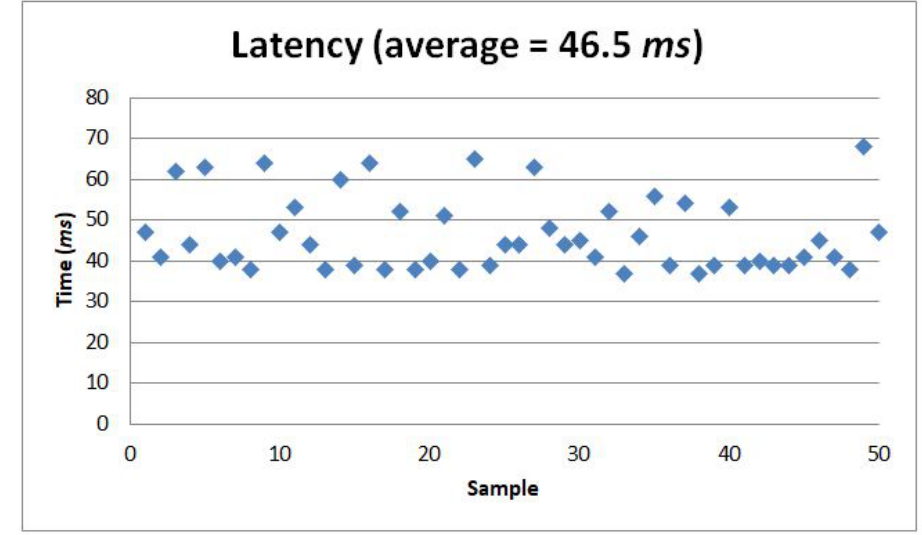
Figure 10. An average of 46.5 ms latency was measured from 50